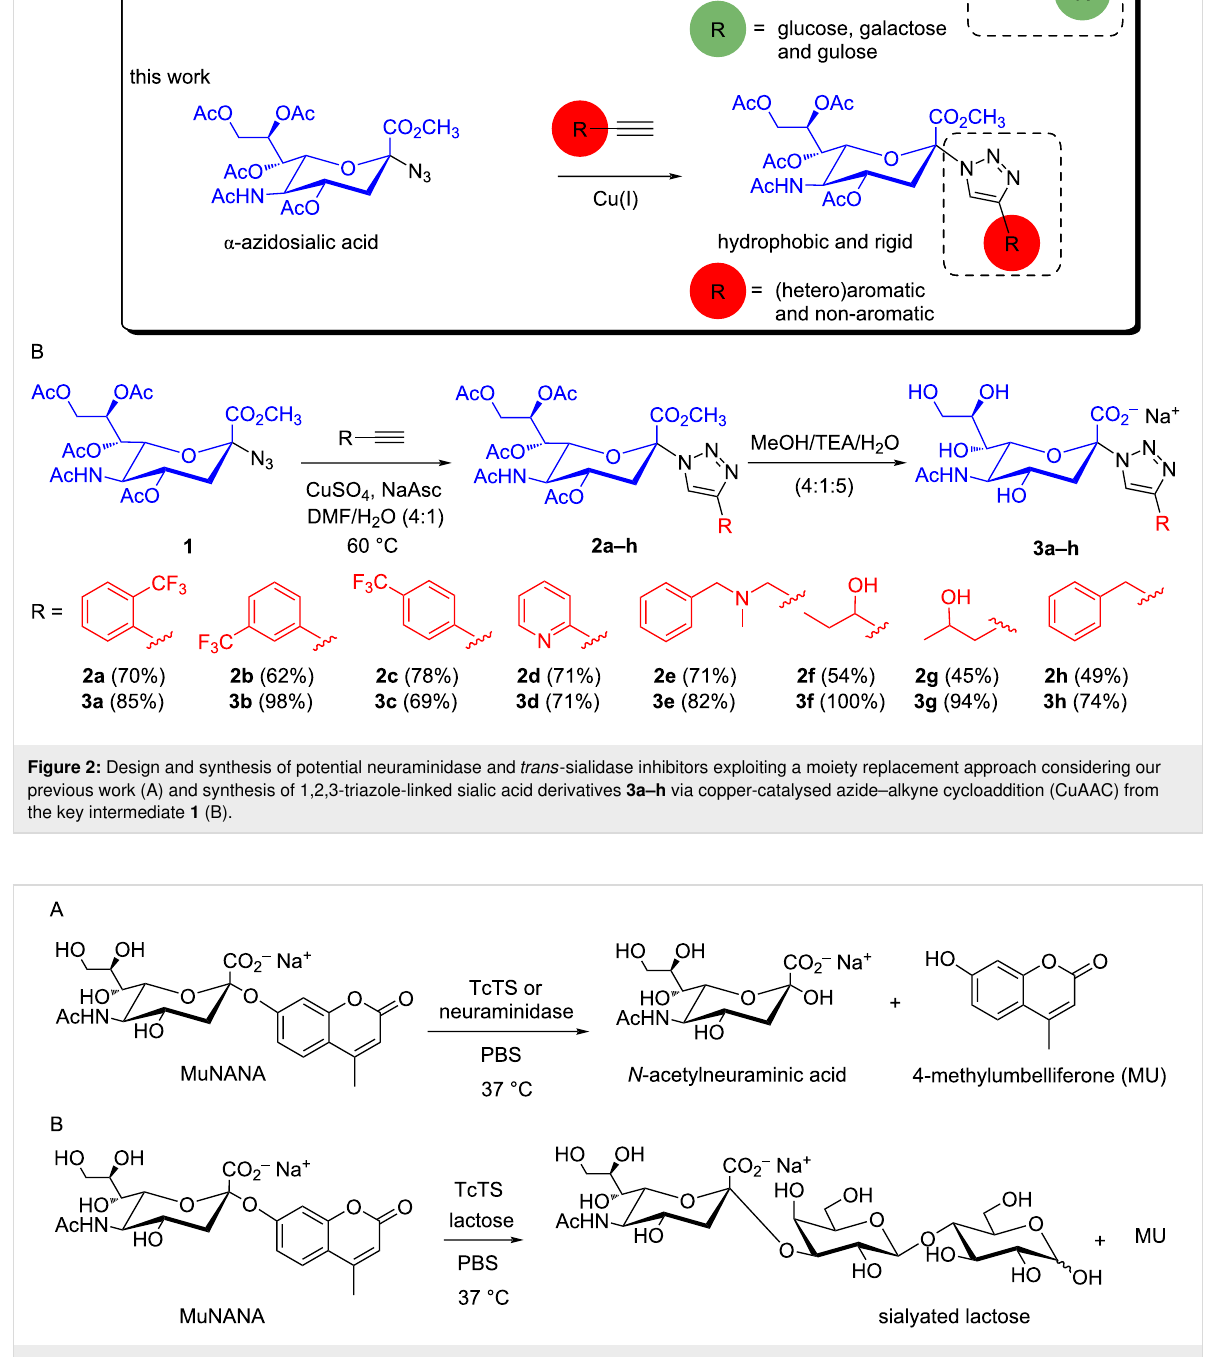
Figure 3: TcTS and neuraminidase hydrolase activity (A) as well as TcTS transferase activity (B) in the presence of an acceptor